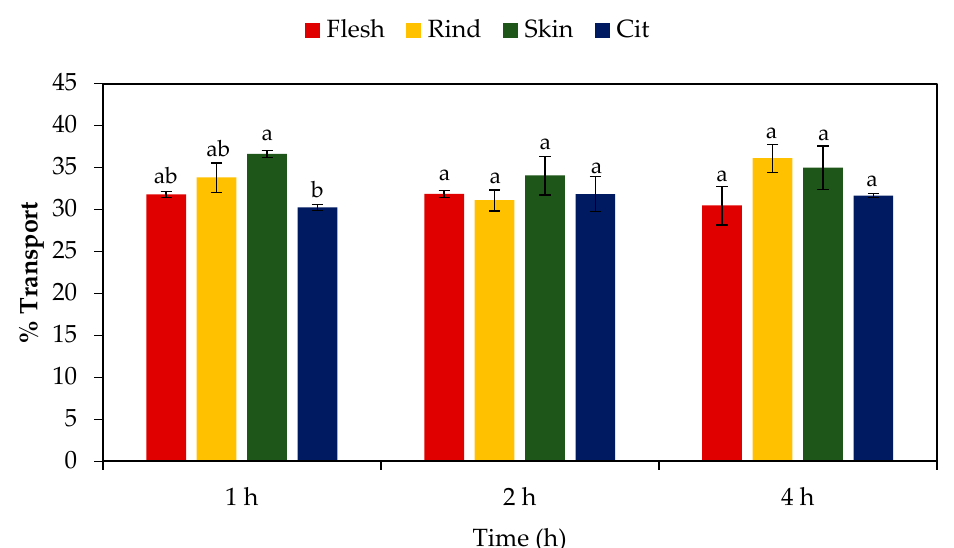
Figure 3. Transport of citrulline in watermelon samples using Caco-2 cell assays after 1, 2, and 4 h incubation. Data are presented as mean ± SEM (n = 2). % Transport was calculated as the percentage transported across the cell monolayer from the apical to the basolateral chamber. Different letters in the same treatment time indicate significant differences between results at the 5% level.